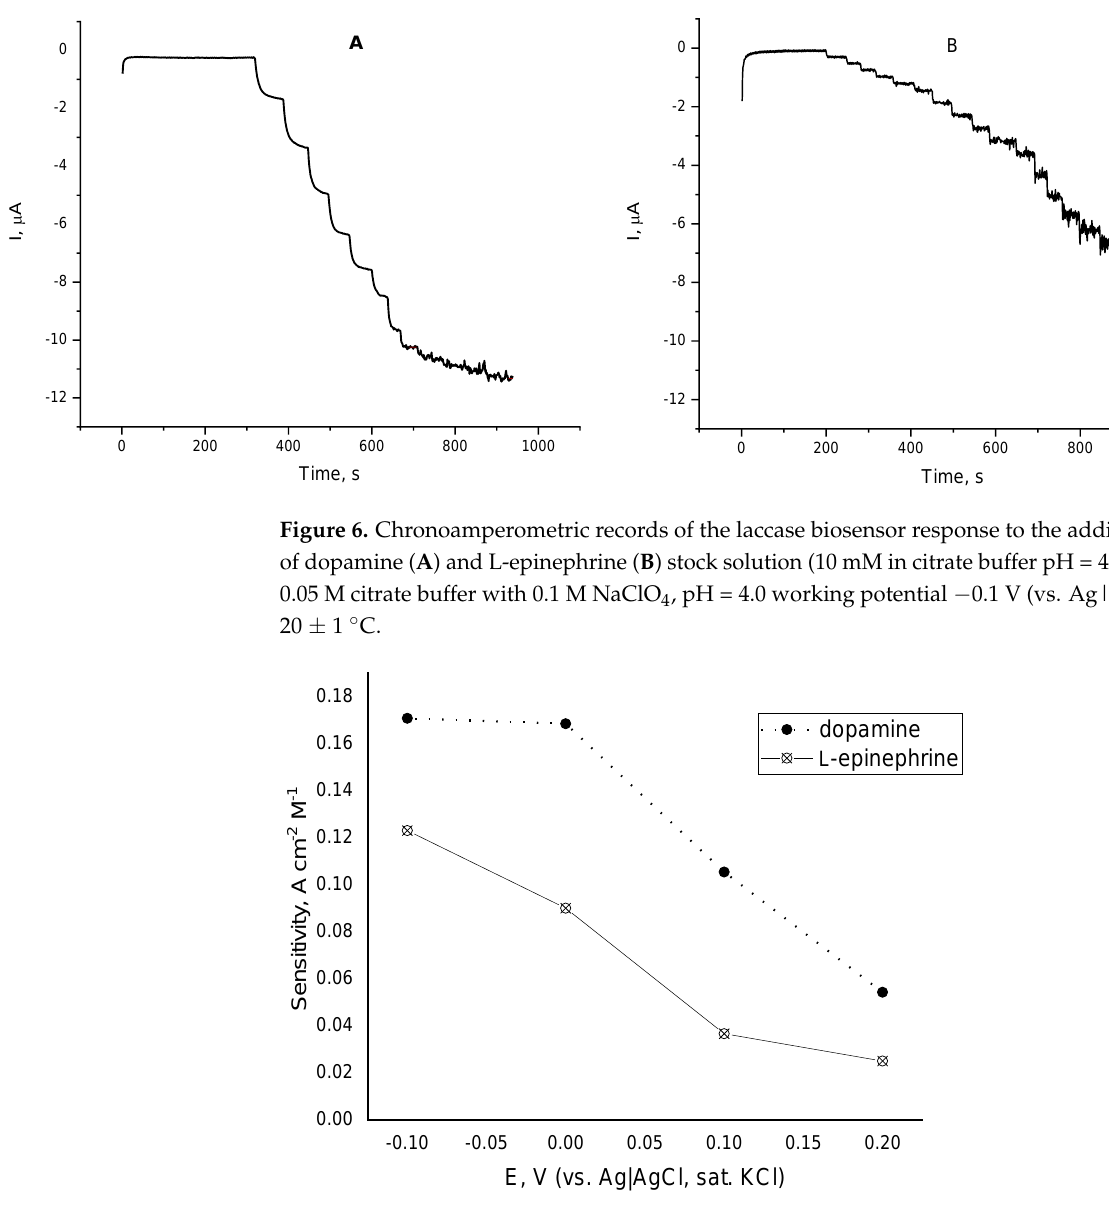
Figure 7. Sensitivity of the determination of dopamine (closed circles) and L-epinephrine (open circles) vs. operating potential over the potential region from − 0.1 to 0.2 V (vs. Ag|AgCl, sat. KCl); electrolyte — 0.05 M citrate buffer with 0.1 M NaClO 4 , pH = 4.0; 20 ± 1 °C.